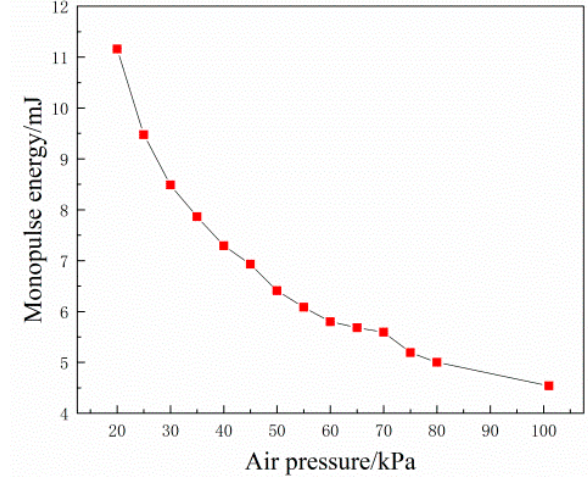
Figure 9. One pulse energy at different air pressure levels.